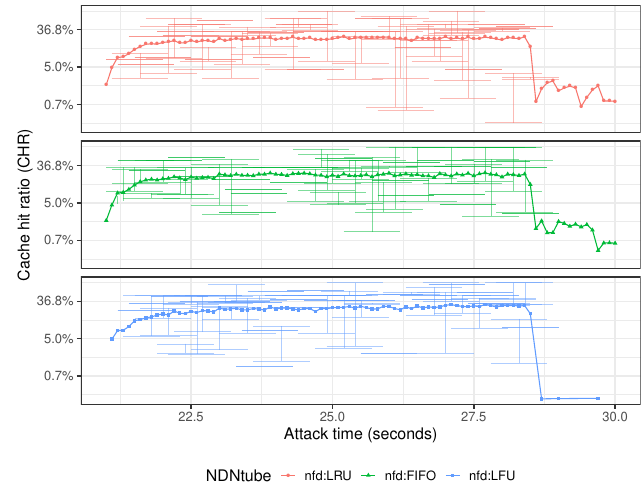
Figure 13. NDNtube brute-force attack performance on CS scenarios. The hops between the NDN routers are identified by “hop counts”. During an attack, the hop count can be decreased and used to identify the adversary’s faces. Figure 14 illustrates the global hop counts for the adversary and legitimate node faces on NDNtube in LRU, FIFO, and LFU scenarios during the simulation time (0–60 s). In these results, the average, minimum, and maximum of hop counts were illustrated for the adversary and the legitimate faces, respectively. The following average hop counts were obtained: i . adversary faces, 1.40 in nfd:LRU, 1.95 in nfd:FIFO, and 1.52 in nfd:LFU. ii . legitimate faces, 3.72 in nfd:LRU, 4.15 in nfd:FIFO, and 4.15 in nfd:LFU.